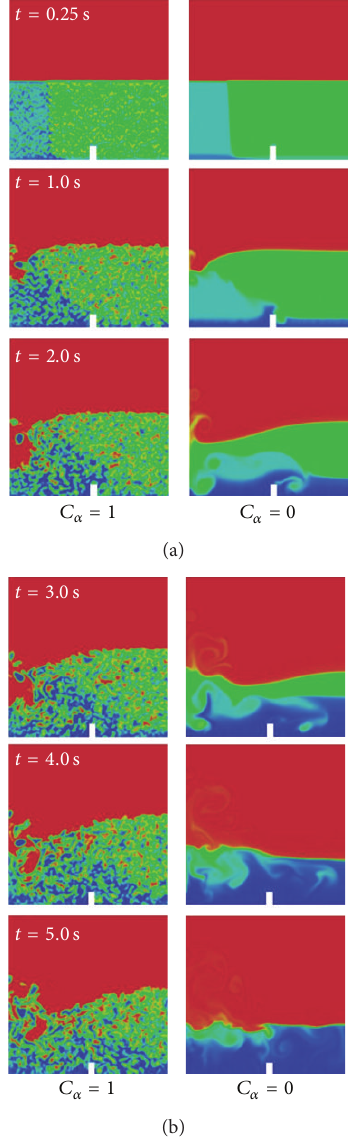
Figure 3: Comparison of simulation using the solver with 𝐶 𝛼 = 1 (left columns) and 𝐶 𝛼 = 0 (right columns) showing the behavior of VOF versus Euler-Euler. Red is oil and blue is